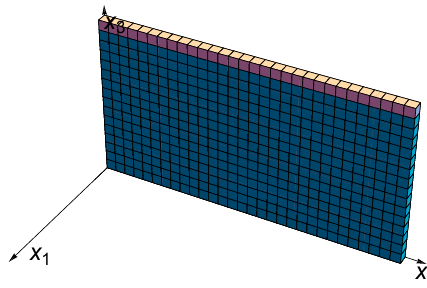
Figure 6 . The conjugate minimal representation. The yellow row of boxes on top of the wall are meant to indicate that only one row of boxes can be